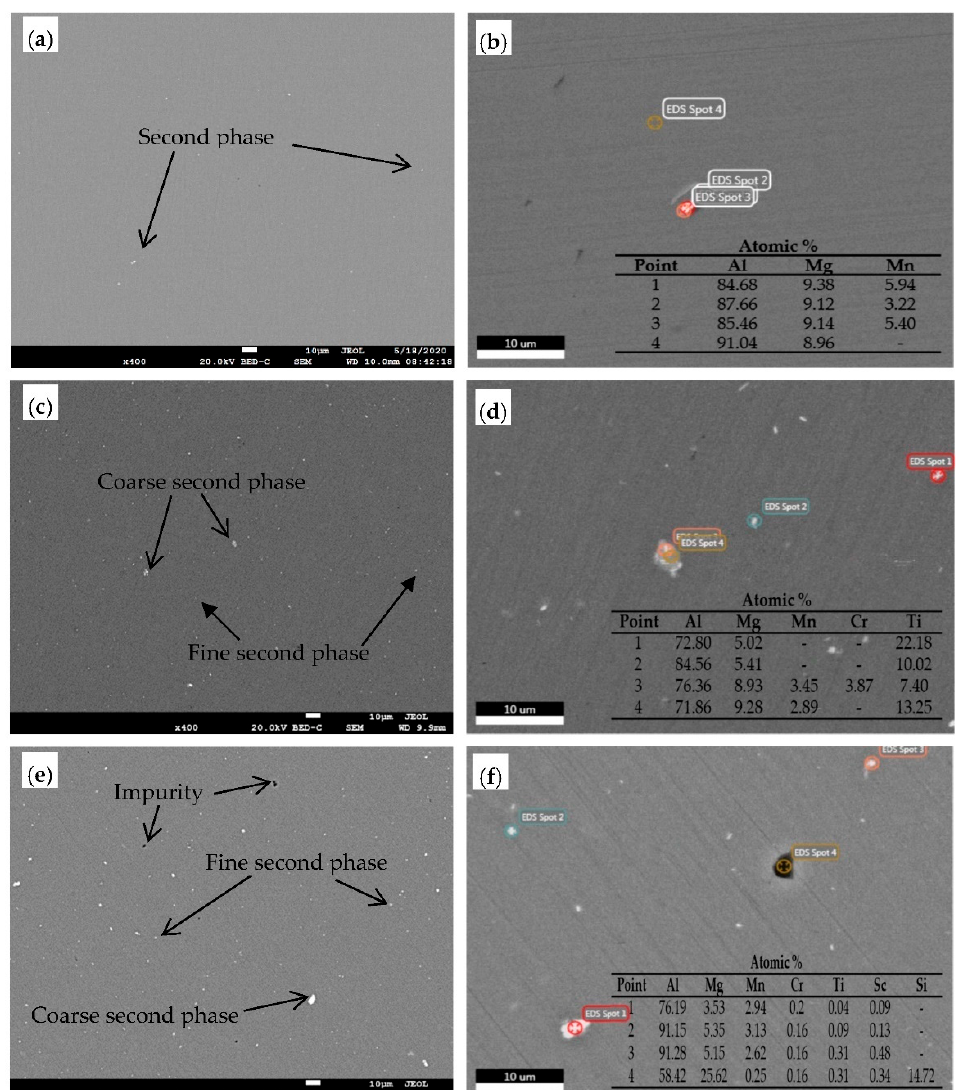
Figure 5. SEM images for Al-Mg alloys: ( a , b ) Alloy 1; ( c , d ) Alloy 2; ( e , f ) Alloy 3.